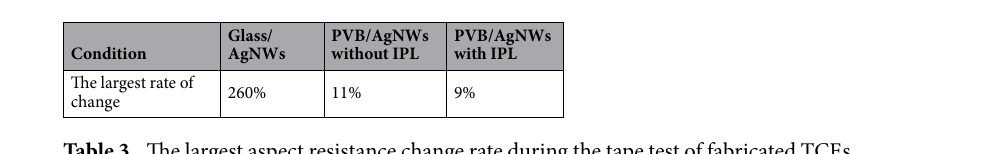
Table 3. The largest aspect resistance change rate during the tape test of fabricated